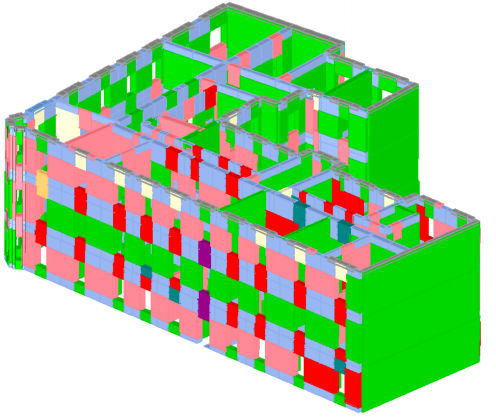
Figure 19. Damage at maximum displacement capacity for pushover in the